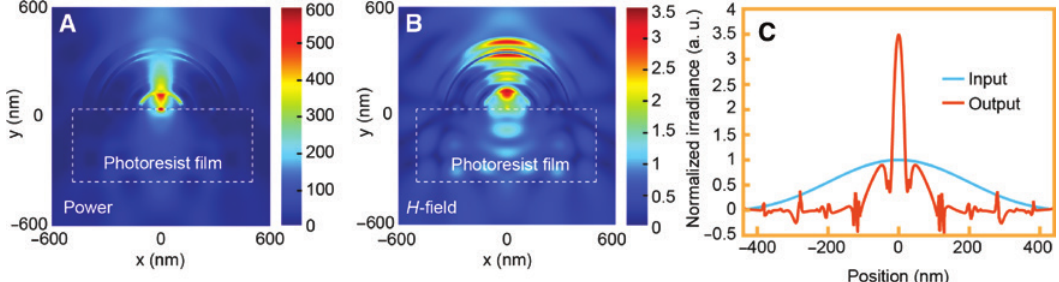
Figure 6: Optimization results. (A) Simulated irradiances and (B) H -field magnitude at λ = 365 nm generated by exact non-paraxial Gaussian beam with a waist of w = λ . The substrate with a refractive index of 1.64 and a thickness of 400 nm are used. (C) Plot of the normalized irradiance for the nanofocusing device with five pairs of binary metal-dielectric layers.